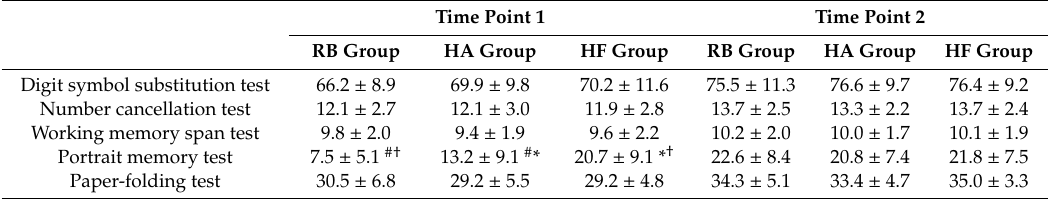
Table 3. Comparison of cognitive performance at di ff erent timepoints between di ff erent groups ( x ± s).